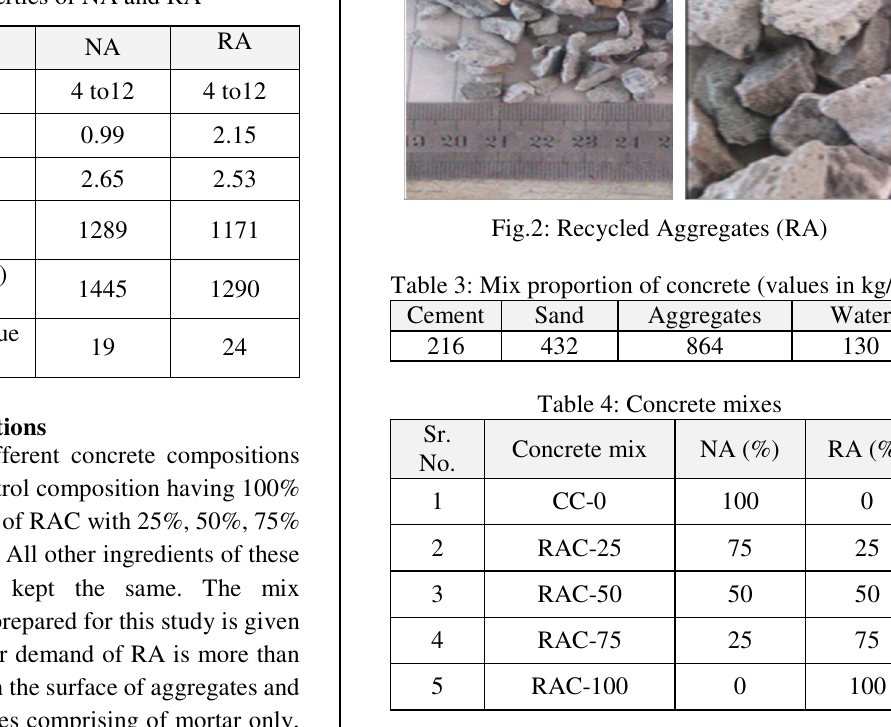
Table 2: Properties of NA and RA